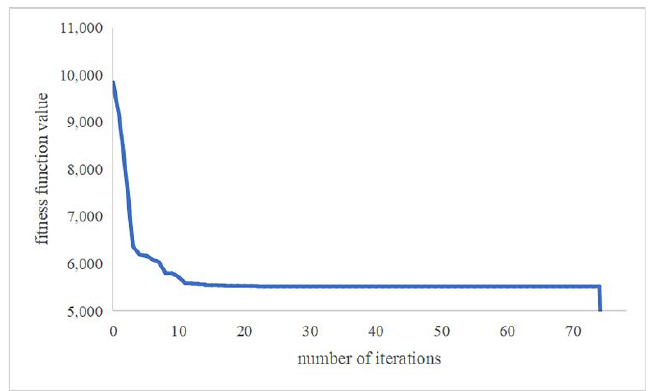
Figure 8. IC-VAINDIWPSO algorithm fitness function convergence graph (50 generations stop running after convergence).